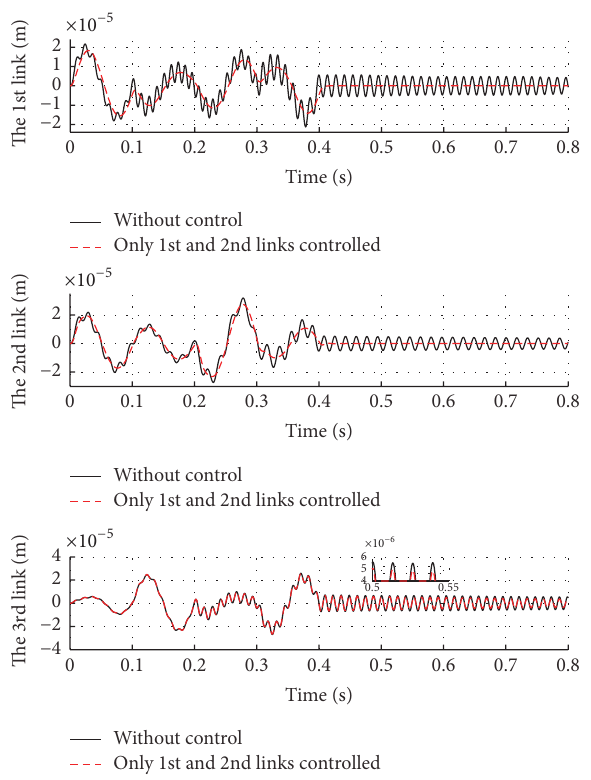
Figure 9: The vibration response of the three flexible links under the third